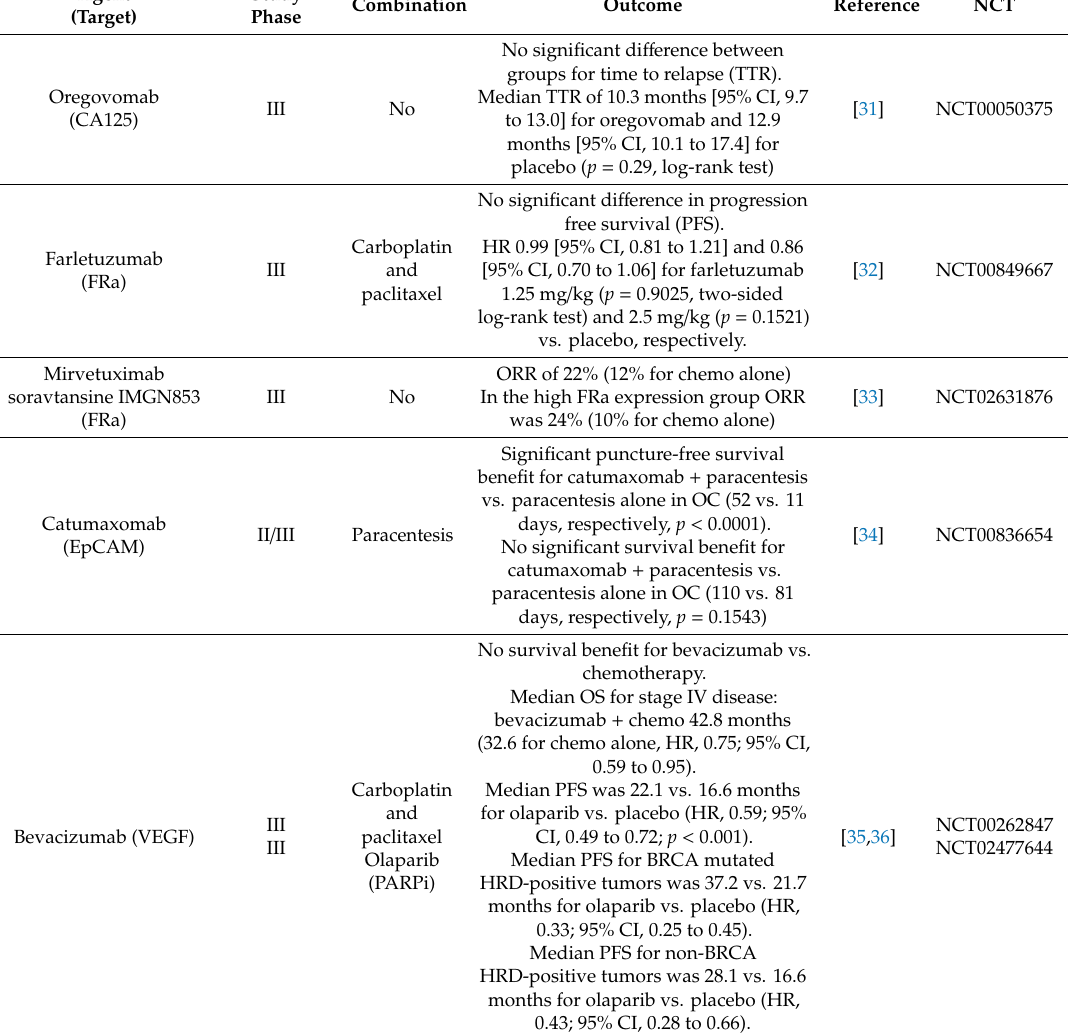
Table 1. Summary of phase III EOC clinical trials testing tumor-targeting monoclonal antibodies (mAb). Agent Study (Target)